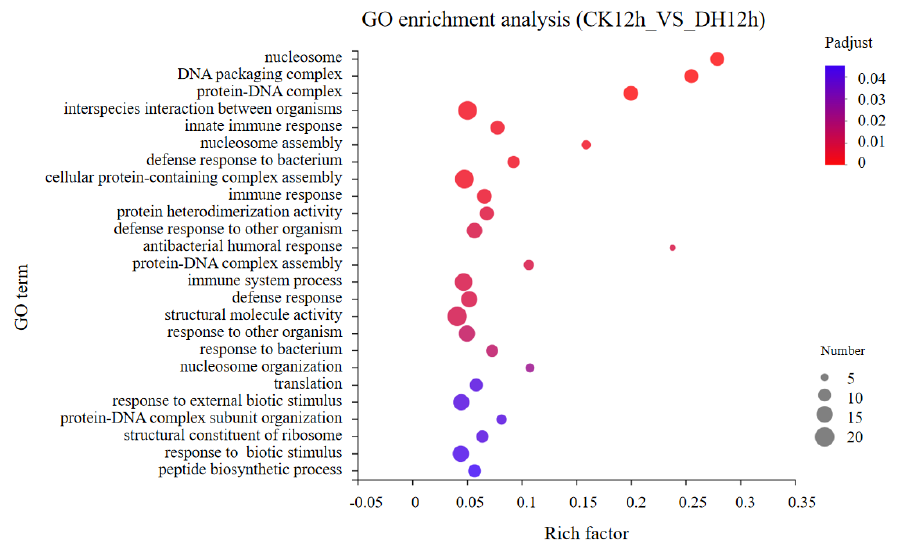
Figure 5. GO enrichment of DEGs in CK12h_vs._DH12h group. The vertical axis represents GO term and the horizontal axis represents rich factor. A greater rich factor indicates a greater degree enrich- ment. The size of the plot represents the number of DEGs in this GO term. The color of the plot corresponds to different p −adjust ranges.